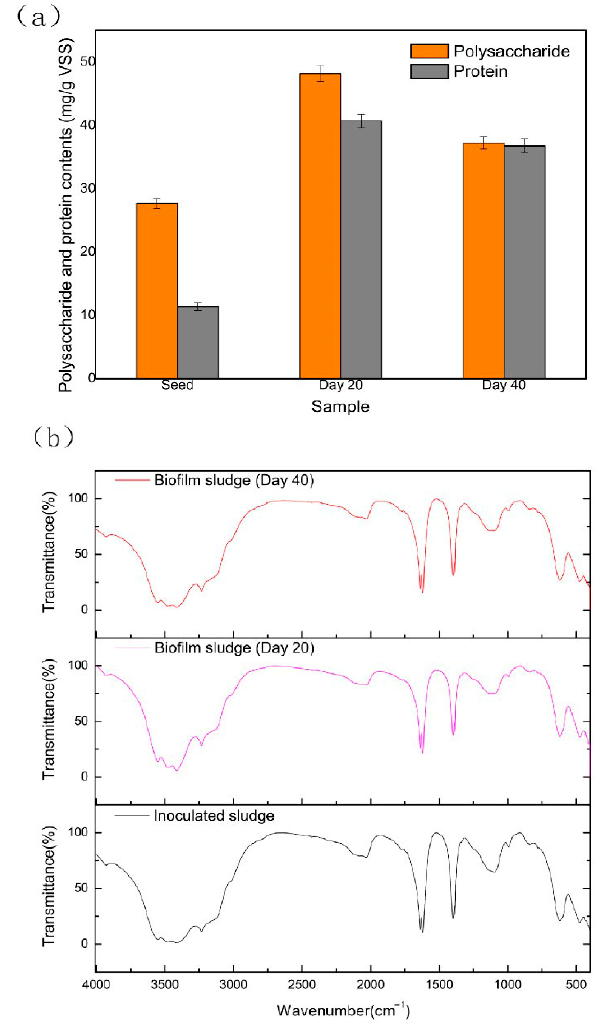
Figure 4. EPS comparison of inoculated sludge and biofilm sludge in the WRBC system: ( a ) polysaccharide and protein contents in EPSs; ( b ) enfrared spectra of EPSs.